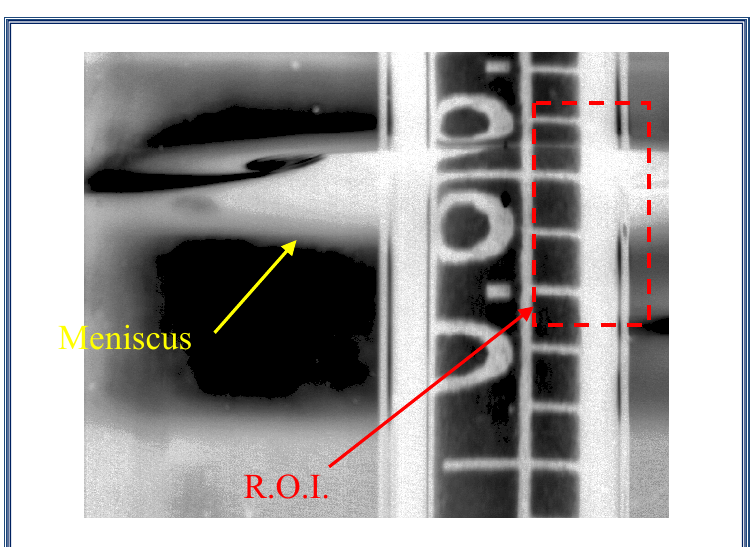
Figure 14. Region of interest